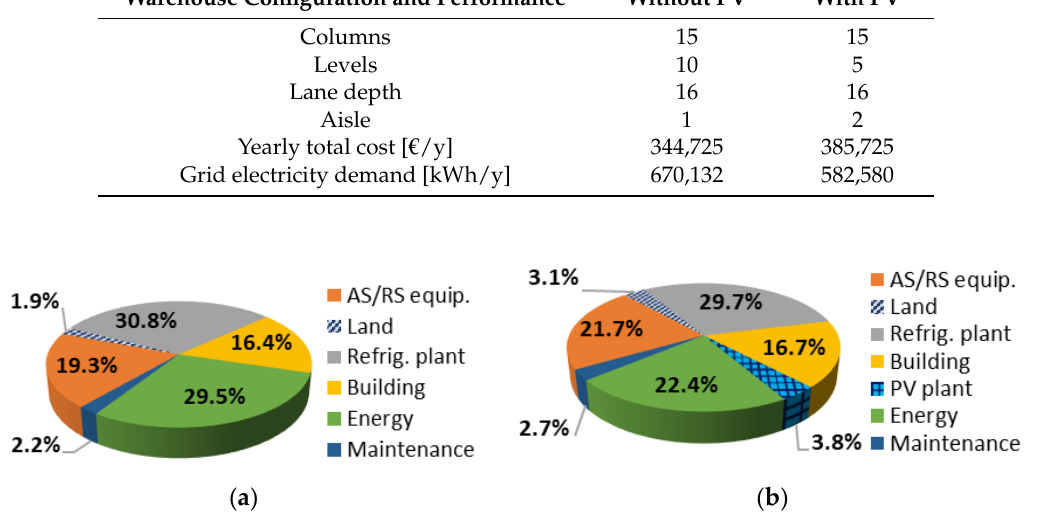
Figure 6. Optimal solution minimizing grid electricity demand: yearly cost structure ( a ) without and ( b ) with PV plant.